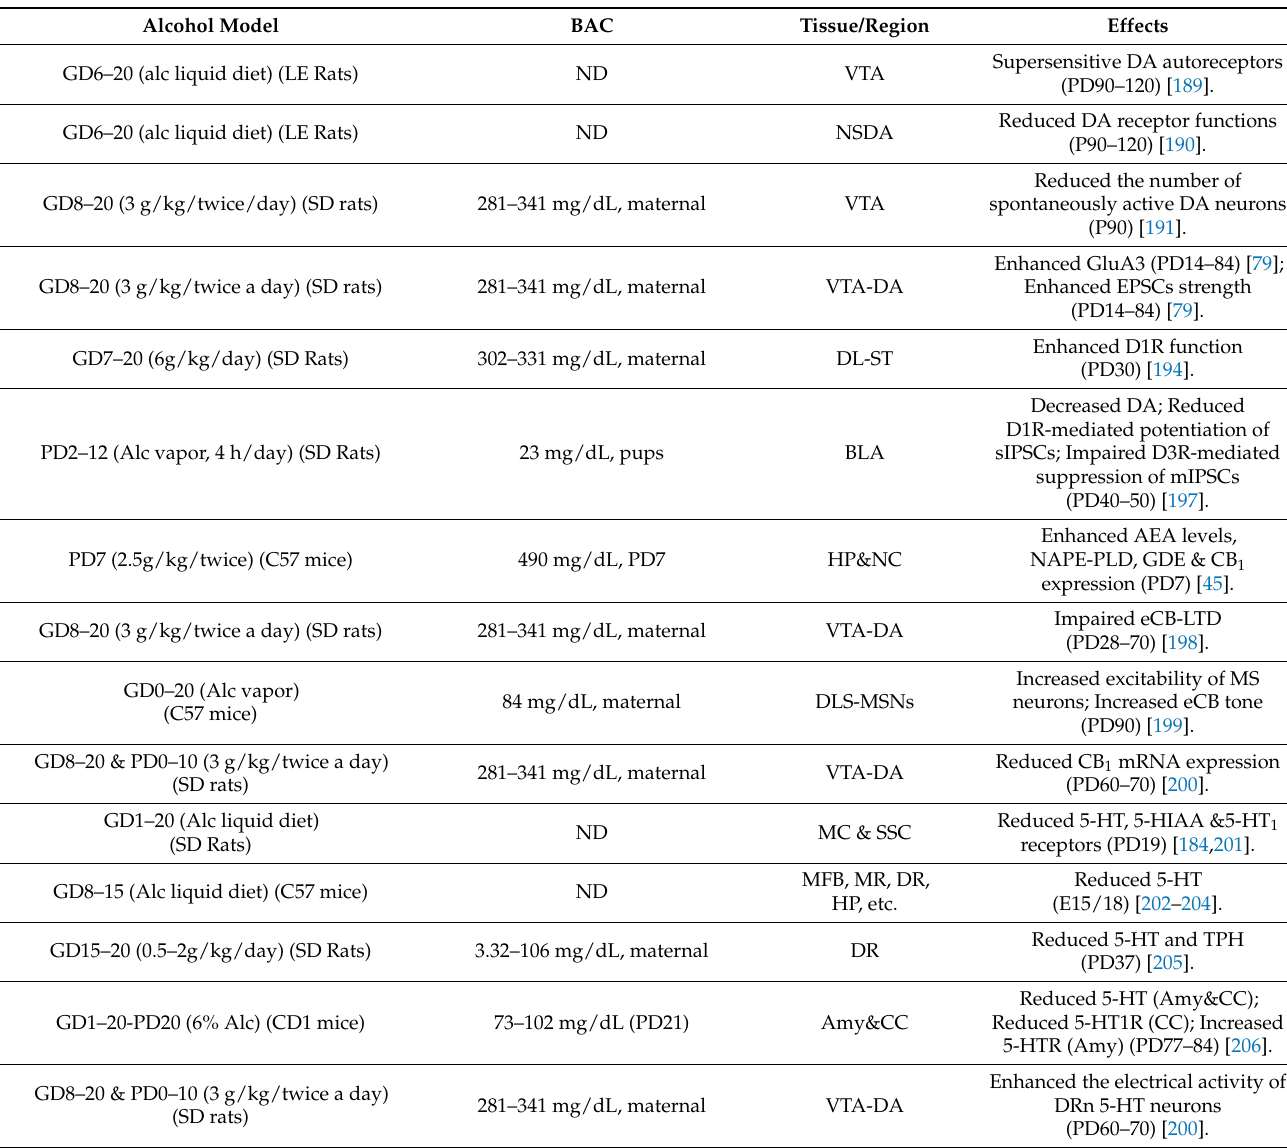
Table 4. Summary of the influence of developmental alcohol on modulators of glutamatergic and GABAergic neurotransmitter